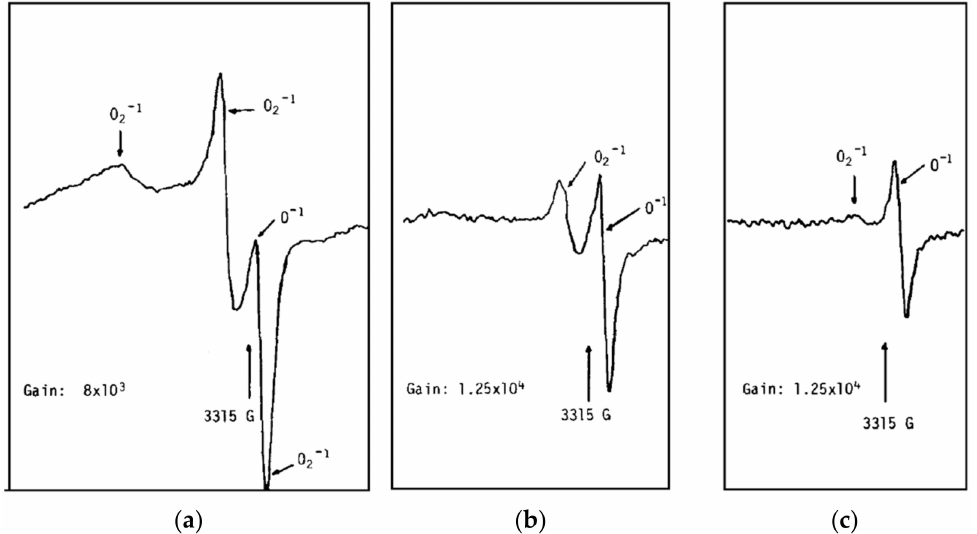
Figure 3. ESR spectra of SnO 2 in UHV. The sample was calcined in UHV at 550 ◦ C for 4 h. ( a ) Sample at 20 ◦ C. ( b ) The sample was warmed up to 100 ◦ C. ( c ) The sample was warmed up to 150 ◦ C. Reproduced with permission from Reference